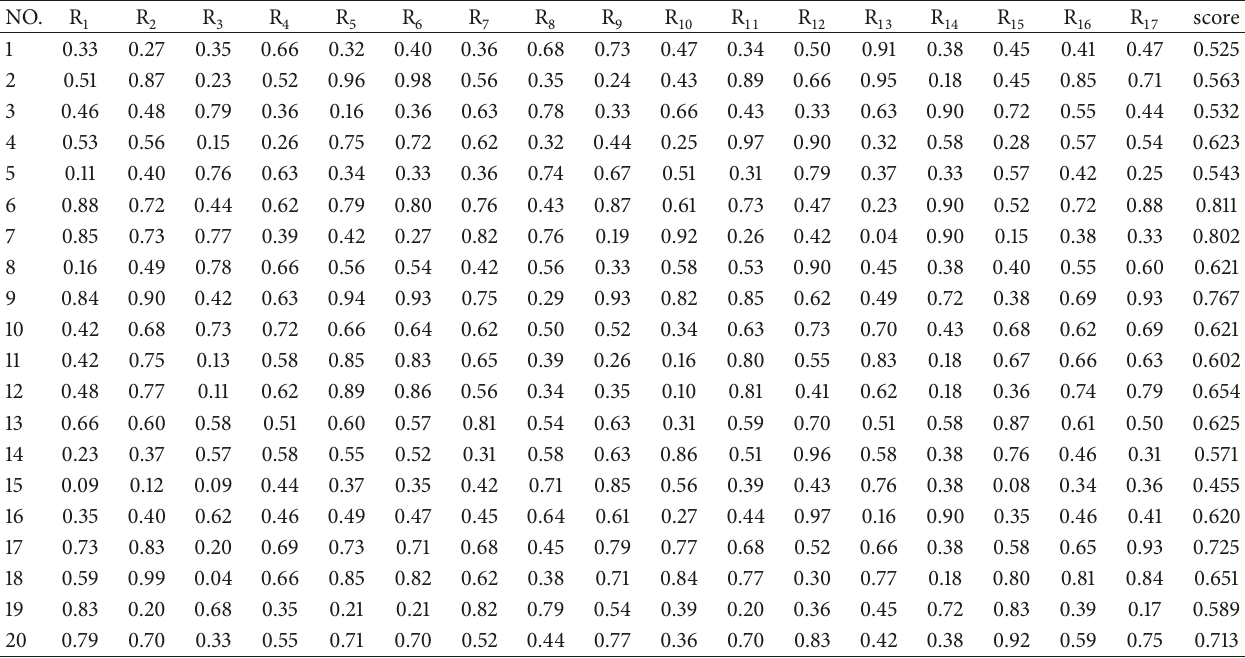
Table 8: Risk scores for railway construction projects in 20 countries in Europe.